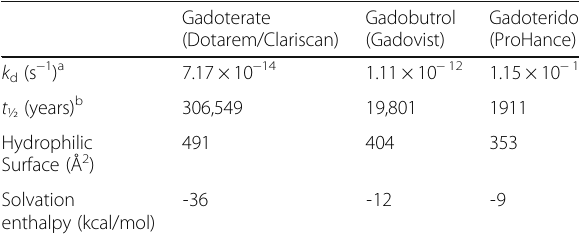
Table 2 Physico-chemical features of the gadoterate, gadobutrol, and gadoteridol molecules Gadoterate Gadobutrol (Dotarem/Clariscan) (Gadovist)